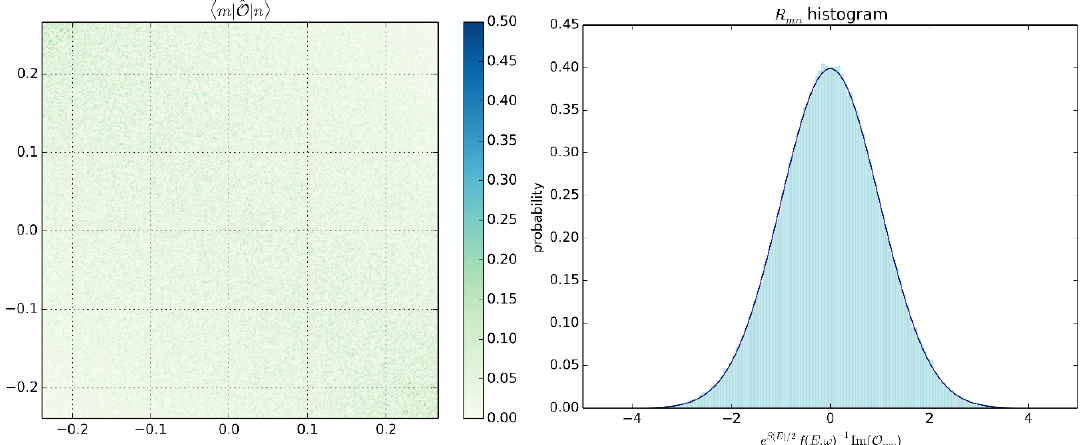
Figure 8 . Absolute values of matrix elements jQ nm j = jh n jQj m ij for the two-site hopping operator Q = ^ h N (cid:0) 1 ;N at half (cid:12)lling (cid:23) = 1 for a single realization. Left panel : we show the absolute values 2 of matrix elements against their energies E n =J for N = 10, labelled along horizontal and vertical axes. The reason one sees no clear structure along the diagonal is that the thermal expectation value Q ( (cid:22) E ) (cid:25) 0 for almost all energies as illustrated below in (cid:12)gure 9. Right panel: histogram of the remainders R mn for 1000 realizations at N = 12. As we see these are accurately (cid:12)t by a unit width Gaussian with zero mean con(cid:12)rming the ETH ansatz (2.1). Again we have veri(cid:12)ed this for other accessible values of N